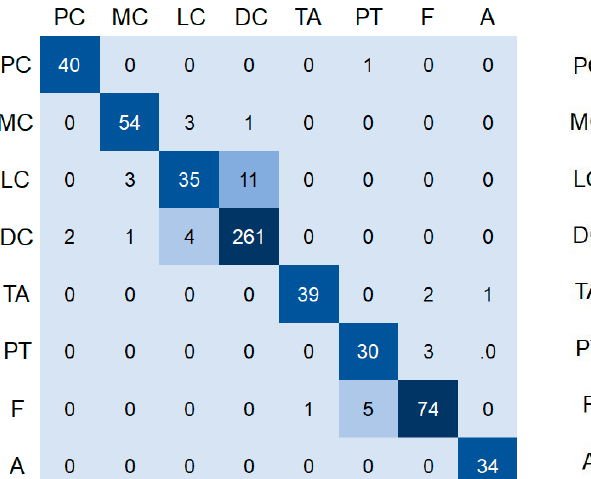
97.74 Table 5. Multi-class classification accuracy comparison. Methods